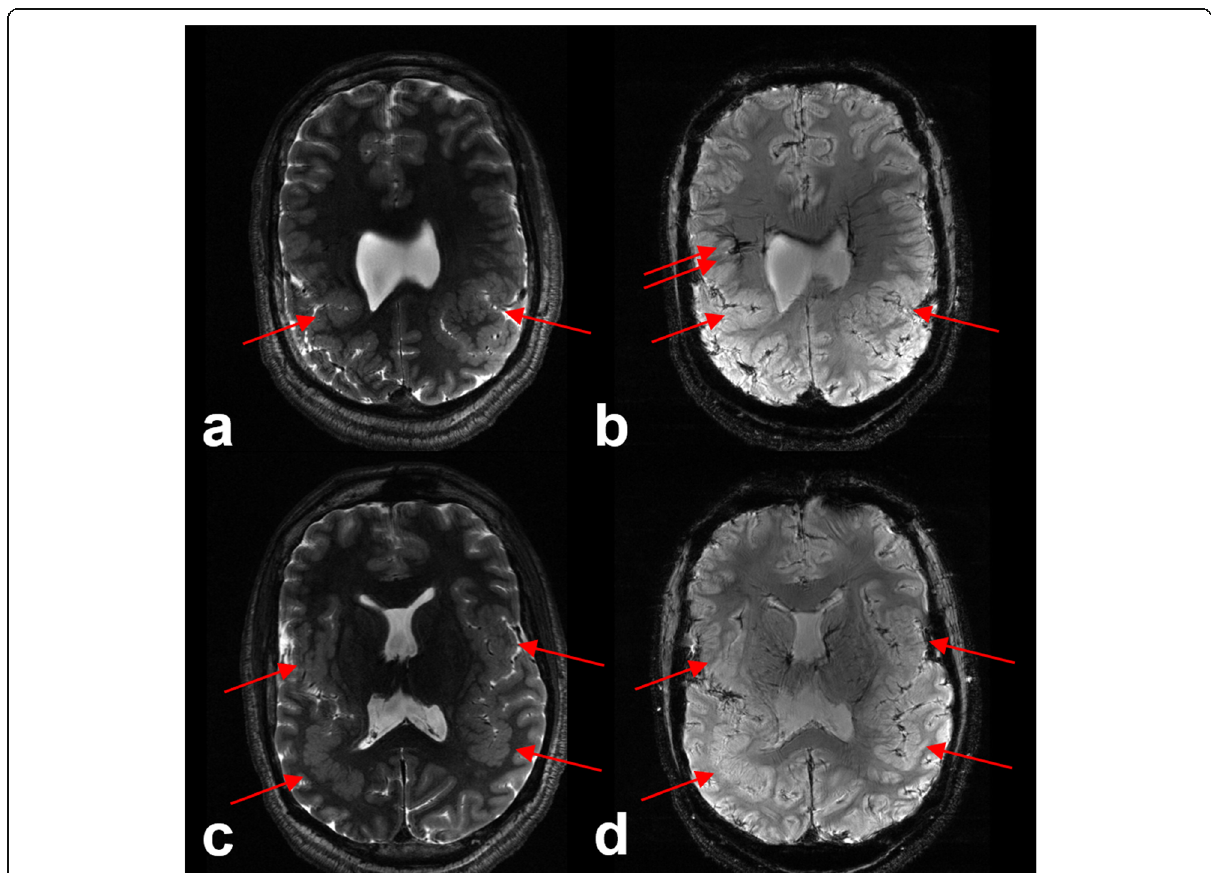
Fig. 4 Sensitivity of 7T magnetic resonance imaging for polymicrogyria. Axial T2-weighted and susceptibility-weighted images at the level of the centrum semiovale ( a , b ) and lateral ventricles ( c , d ) demonstrate simplification of the gyral folding pattern involving the perisylvian cortex bilaterally, including the posterior temporal lobes and parietal lobes (red arrows), with thickening of the cortex and nodularity, consistent with polymicrogyria. There is also an abnormally large draining vessel on the right ( b , red arrow), which may represent a developmental venous